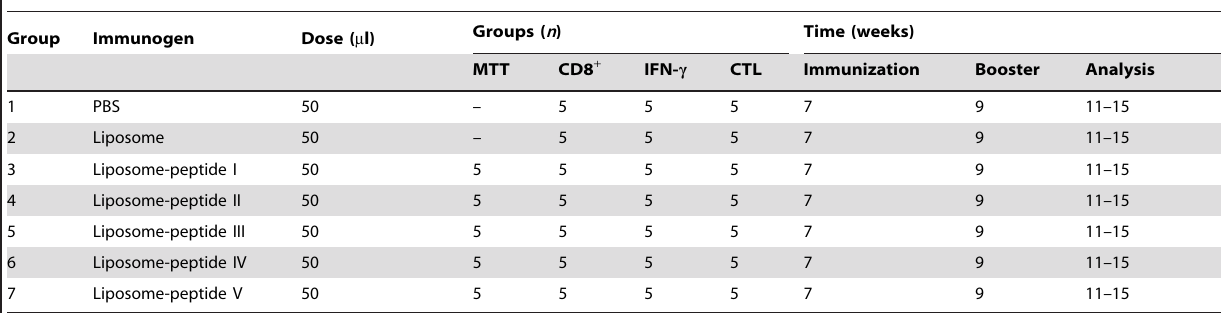
Table 2. Schedule for peptide